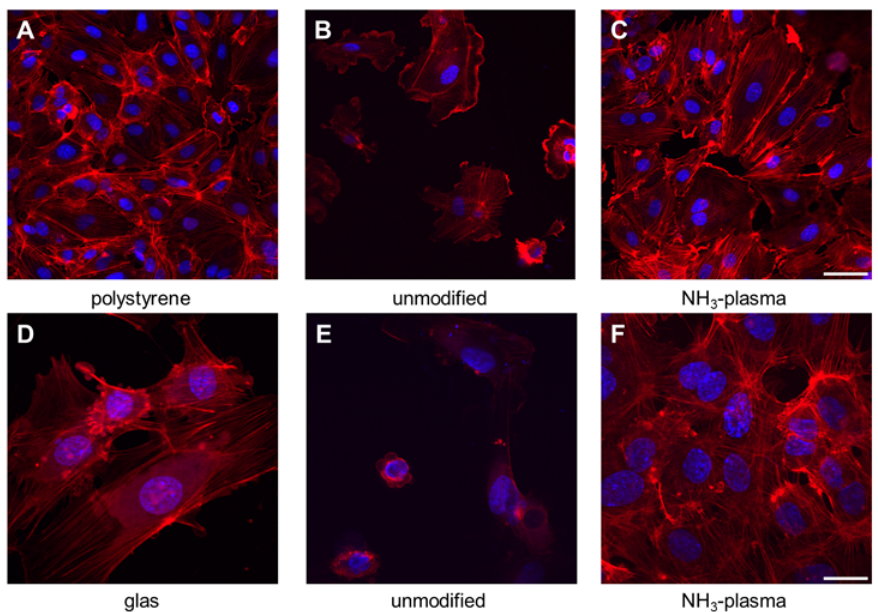
Fig 6. Representative micrographs of HUVEC grown on polystyrene and two different unmodified and modified polymers. Confocal micrographs of actin-stained HUVEC (red staining) grown on polystyrene (A), glass (D) and unmodified polymers P(DLLA-co-GA) (B) and PLLA (E). A better cell adhesion and actin filament on NH 3 -activated P(DLLA-co-GA) (C) and PLLA (F), when compared to the respective polymers in unmodified state ((B) and (E), respectively). Overall, the blue staining (Hoechst-staining) indicates cell nuclei. Scale bars = 50 μ m in (A), (B), (C) and 20 μ m in (D), (E) (F).